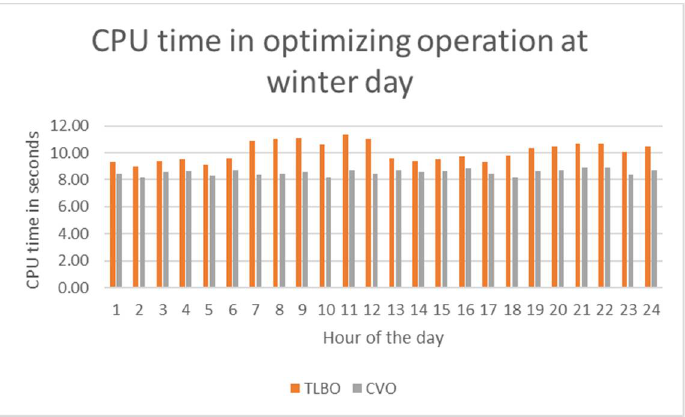
Figure 13. CPU time in the operation of TLBO and CVO at each hour of a summer day.